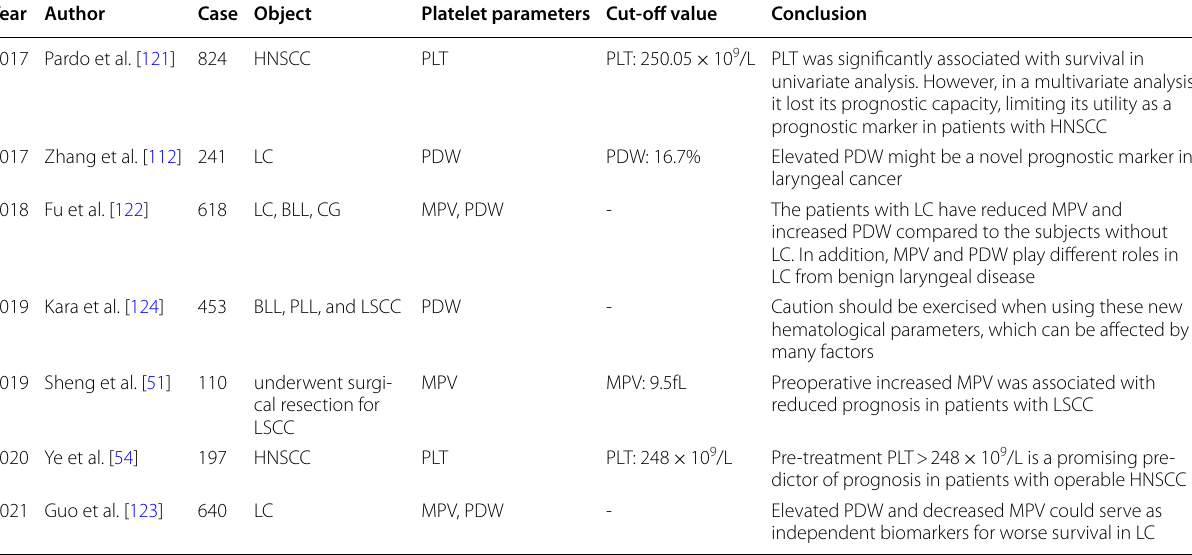
Table 3 Clinical studies in which predictive and prognostic roles of PLT, MPV, and PDW were evaluated in patients with LSCC Year